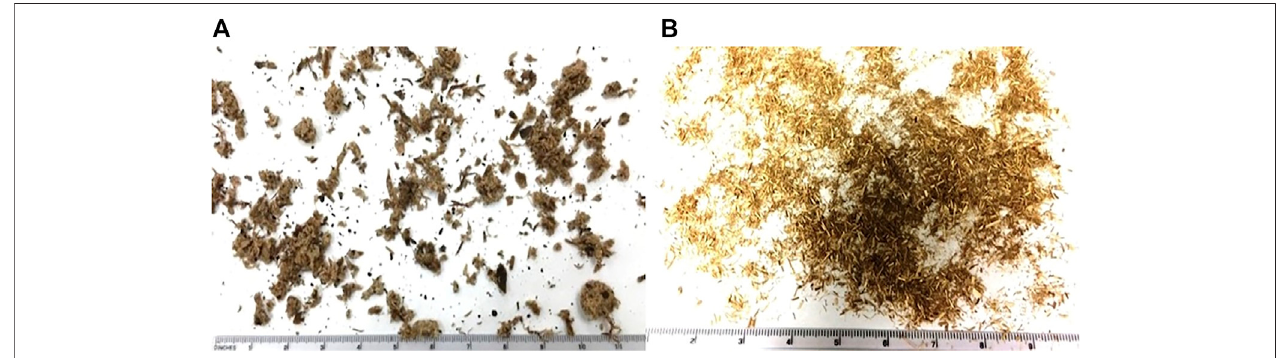
FIGURE 1 | Comparison of woody and herbaceous feedstocks under similar pre-processing particle size reduction. Wood chips (A) and switchgrass (B) were processed with a hammer mill with screen size #10. The particle and conglomerate material attributes differ substantially using similar processing methods. Thus, the need to tailor handling equipment designs for each feedstock is